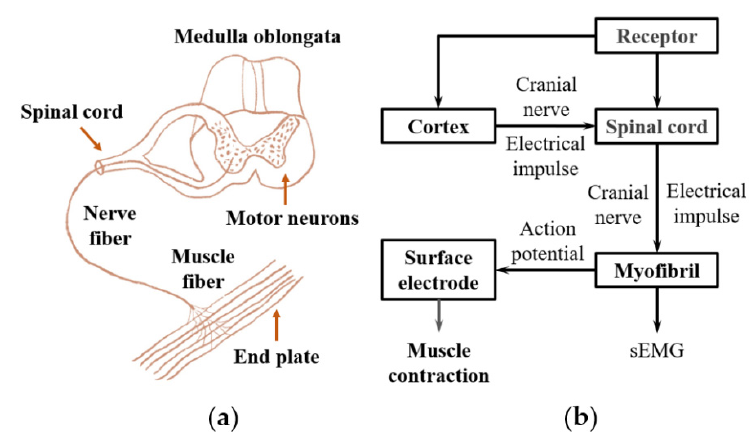
Figure 2. The principle of generation of the EMG signal. ( a ) the structure of the neuro-muscular system. ( b ) the schematic of the EMG signal transduction in the nerve and muscle system.